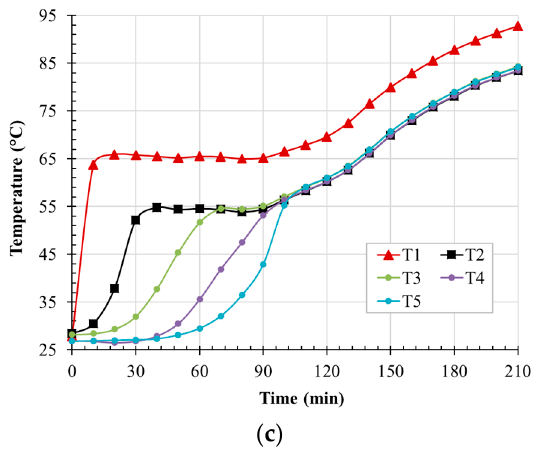
Figure 11. Temperature distribution across heat sink B for RT47 at power ratings ( a ) 1.0 W, ( b ) 1.5 W and ( c ) 2.0 W.